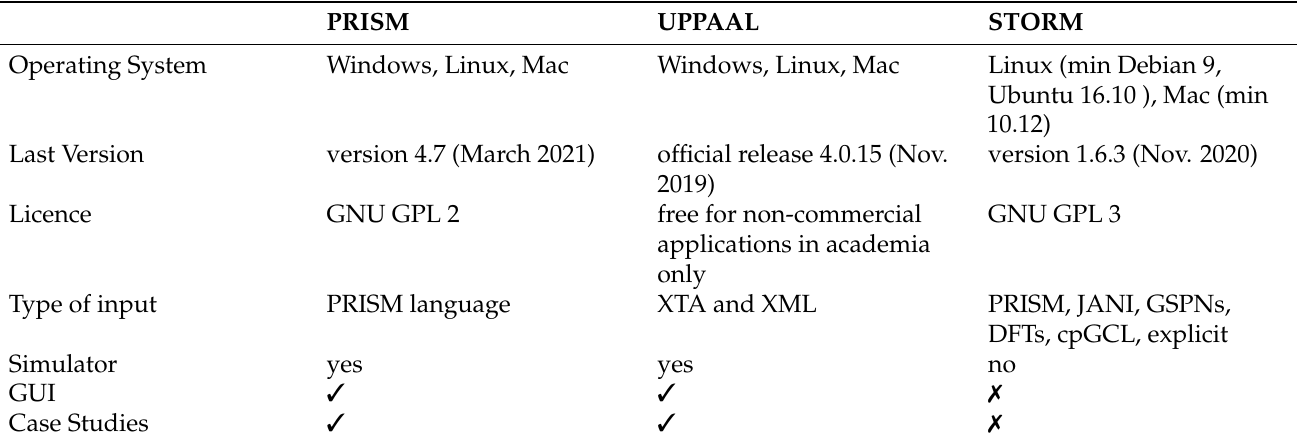
Table 6. Comparison of probabilistic model checking tools.